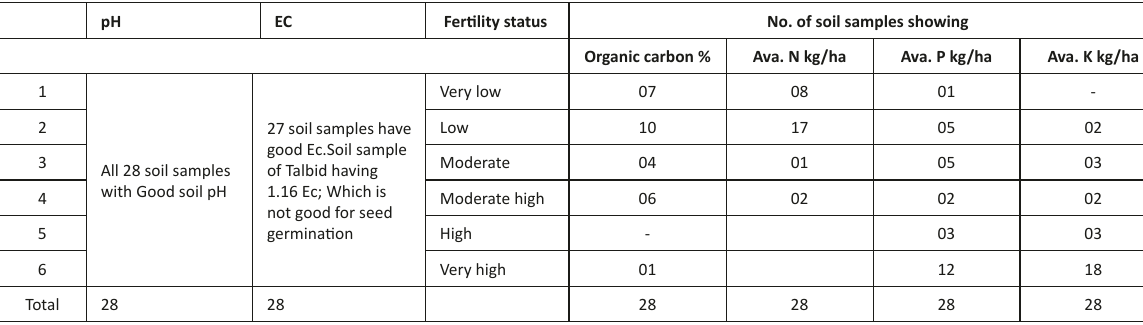
Table 4. Numerical analysis for fertility category of soil samples from Karad Tehsil, Satara District. pH EC Fertility status No. of soil samples showing Organic carbon % Ava. N kg/ha Ava. P